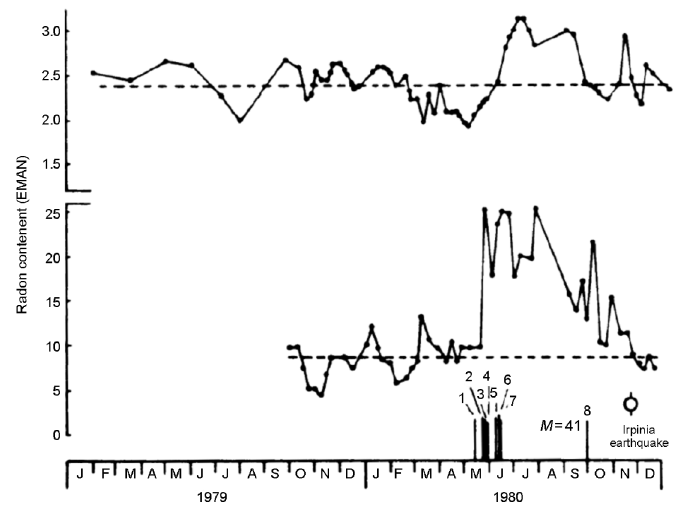
Fig. 2. Radon anomalies registered at Rieti (upper panel) and Rome (bottom panel) stations during period 1979-1980 (after Alegri et al. , 1983).